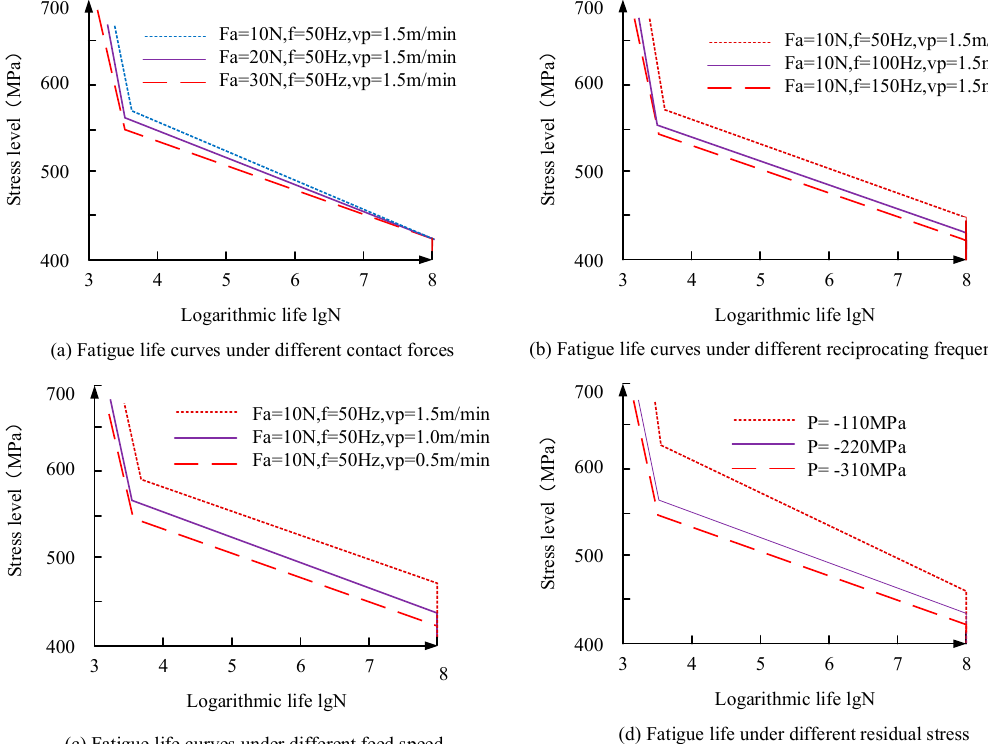
Figure 10. Fatigue life curves: ( a ) under different forces on the surface; ( b ) under a different reciprocating frequency; ( c ) under different feed speed; ( d ) under different residual stress.